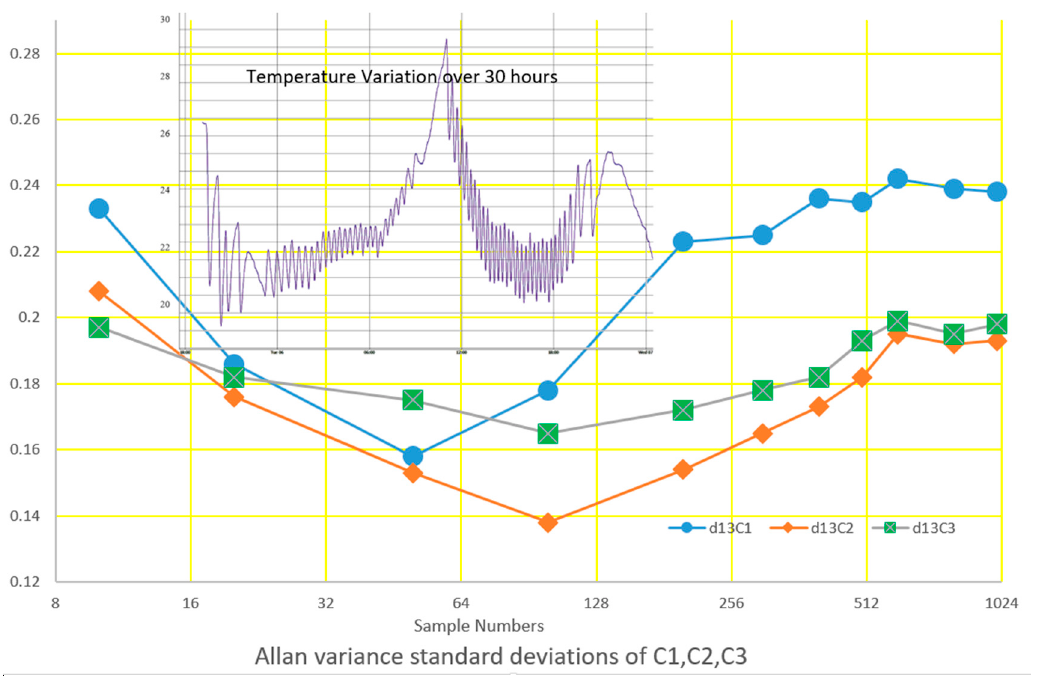
Figure 5. Long term stability of the GC–IR 2 system in terms of standard deviations of the three species’ carbon isotope ratios when the laboratory temperature (see insert) varied close to 10 C.